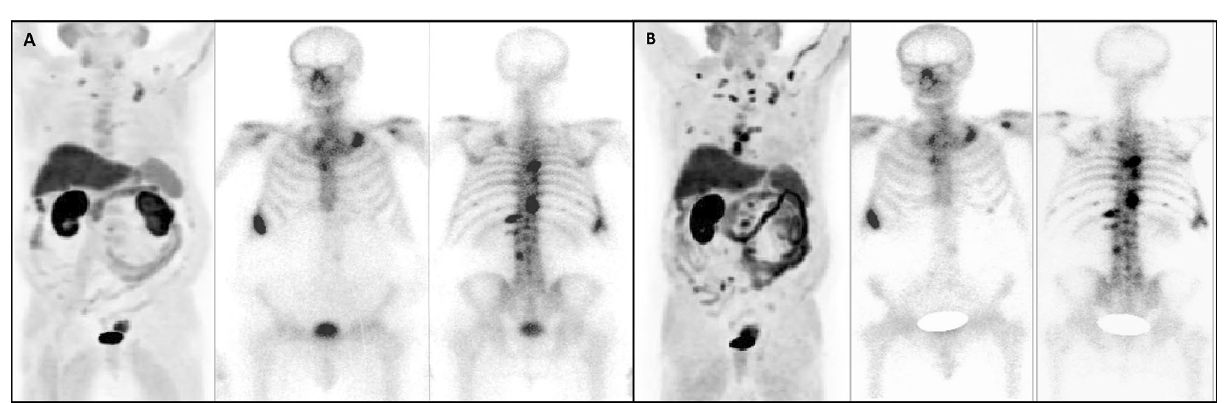
Figure 5. Patient ≠ 3. Baseline ( A ) and interim ( B ) series of FCH PET/CT (left images) and BS (central and right images) show polimetastatic osteoblastic disease. Interim BS was stable with respect to baseline study, whereas progression was detected on interim FCH PET/CT. 82 years old man, Gleason 9, 223 Ra in third line, baseline PSA: 59 ng/ml. PFS of 3 months, under follow-up for